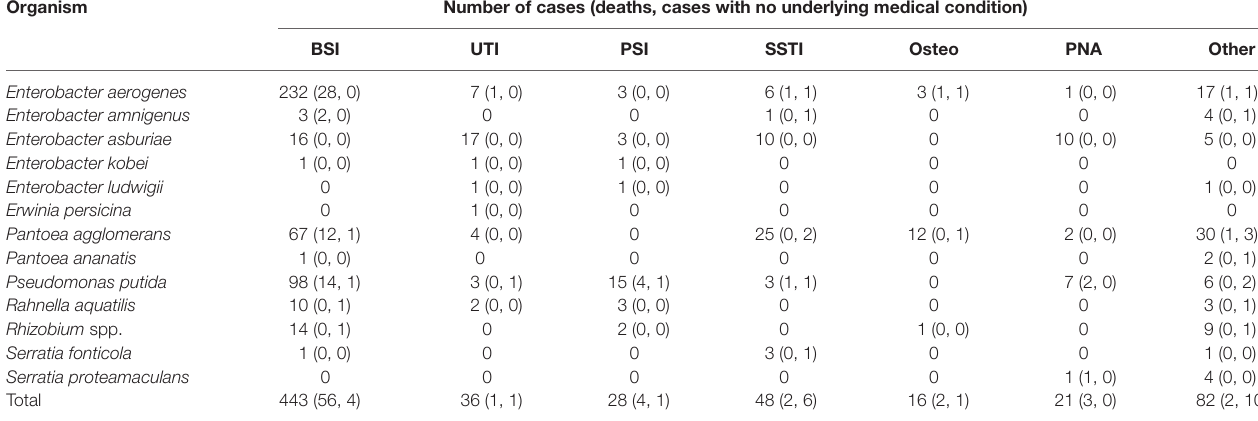
taBLe 2 | Infections caused by saprophytic Gram-negative bacteria organisms. Organism Number of cases (deaths, cases with no underlying medical condition)